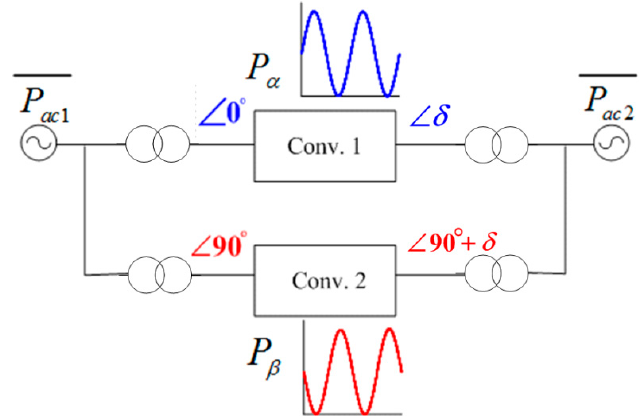
Figure 8. Power fluctuation of two ‐ phase LFAC transmission system.